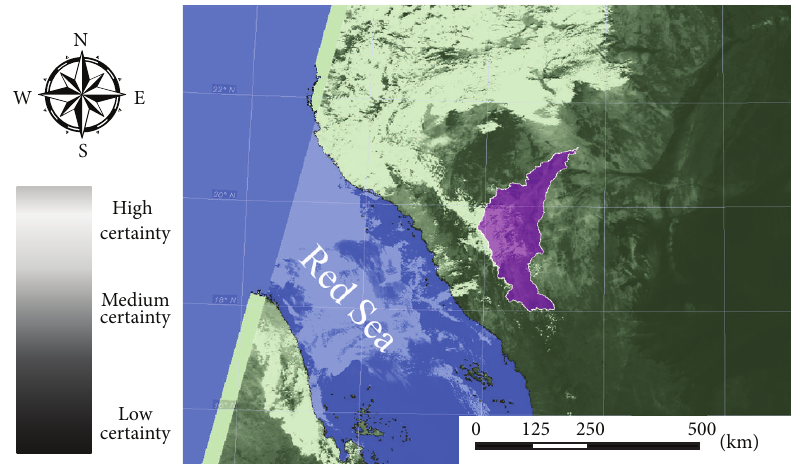
Figure 4: Cloud certainty map with watershed highlighted.